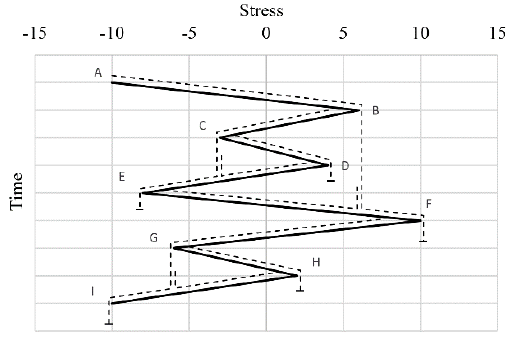
Figure 12. Sample stress history.